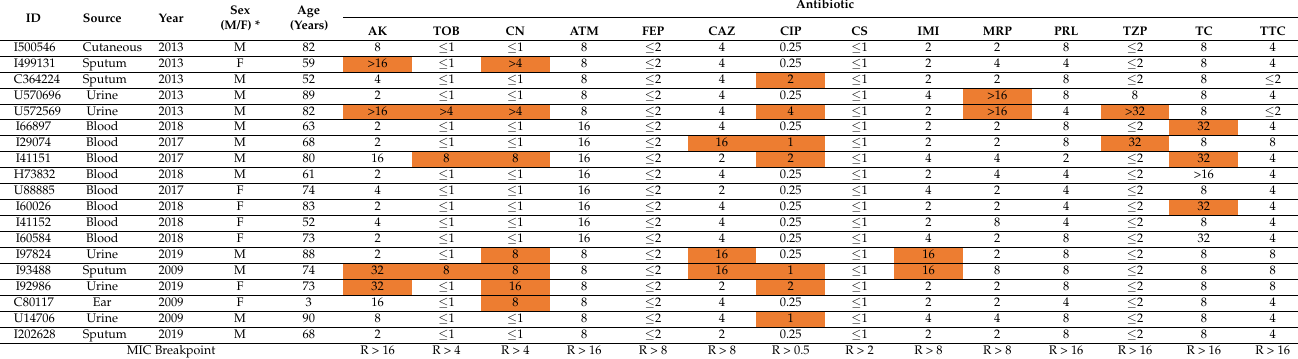
* M: male; F: female. Identification of P. aeruginosa clinical isolates using VITEK2, MicroScan WalkAway as well as MALDI-TOF (for strains isolated after 2017). Antibiograms performed using the Kirby–Bauer method using Müeller–Hinton agar according to CLSI rules (for strains isolated until January 2014) and according to EUCAST afterward using VITEK2 and MicroScan WalkAway. Metallo-beta-lactamases search was done using Etest (imipenem/imipenem + EDTA) and the Kirby–Bauer method using Müeller–Hinton agar. Antibiotics and concentrations tested: AK: amikacin (30 µ g); TOB: tobramycin (10 µ g); CN: gentamicin (30 µ g); ATM: aztreonam (30 µ g); FEP: cefepime (30 µ g); CAZ: ceftazidime (10 µ g); CIP: ciprofloxacin (5 µ g); CS: colistin sulfate (25 µ g); IMI: imipenem (10 µ g); MRP: meropenem (10 µ g); PRL: piperacillin (30 µ g); TZP: piperacillin + tazobactam (36 µ g); TC: ticarcillin (75 µ g); TTC: ticarcillin + clavulanic acid (85 µ g). showing resistance to a particular antibiotic according to the MIC Breakpoint (EUCAST,